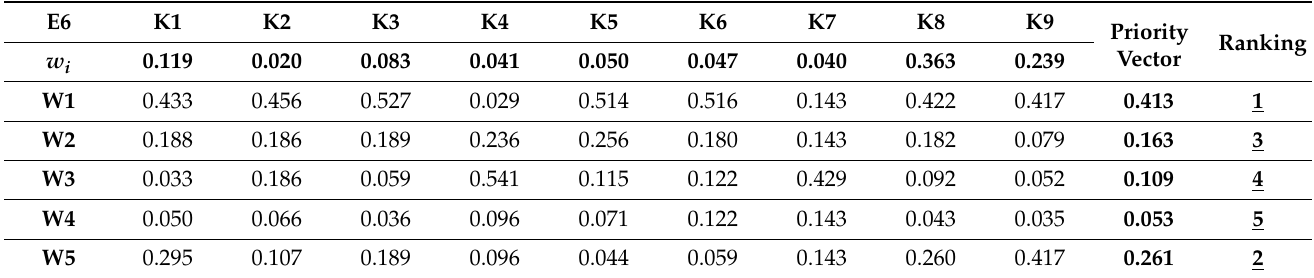
Table 8. Ranked list of the final weight distributions of the respective equipment variants according to Expert 6.